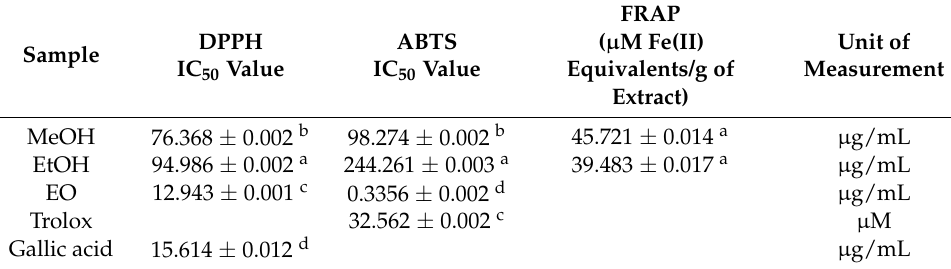
The values followed by the same letter (a, b, c, d) in the same column show no statistically significant differences ( p < 0.01). Each value is the mean of three replicates ± SD.